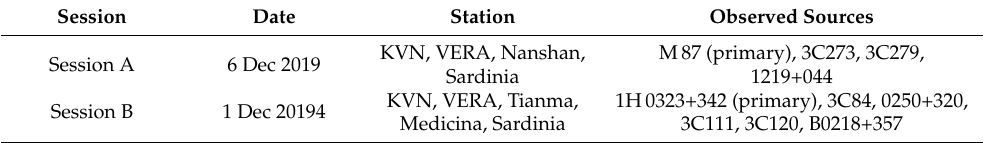
Table 4. EATING VLBI observations presented in this